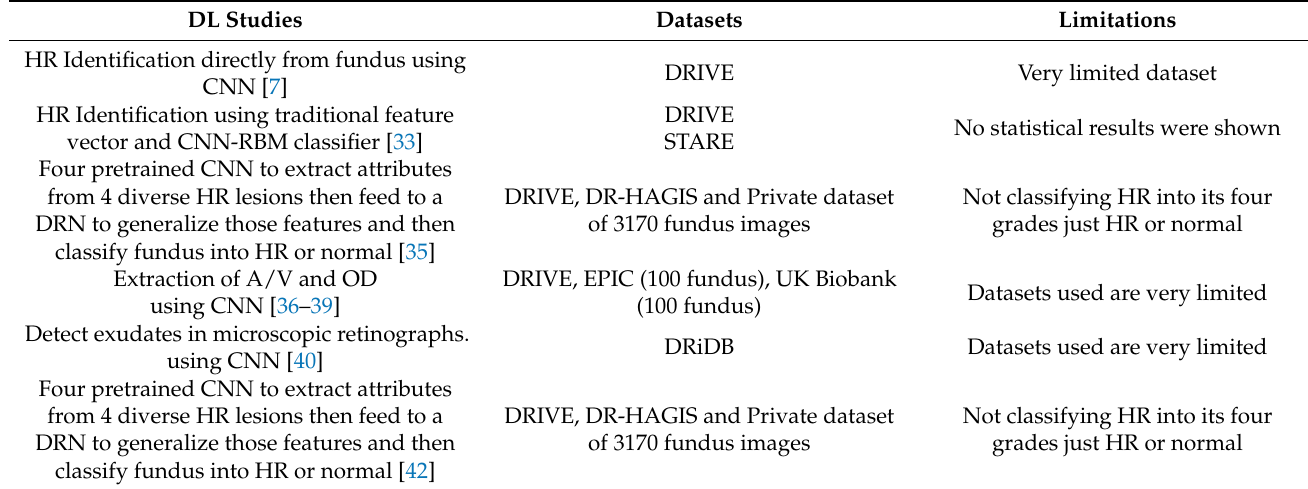
Table 1. Deep learning (DL)-based techniques for retinography photos’ processing and